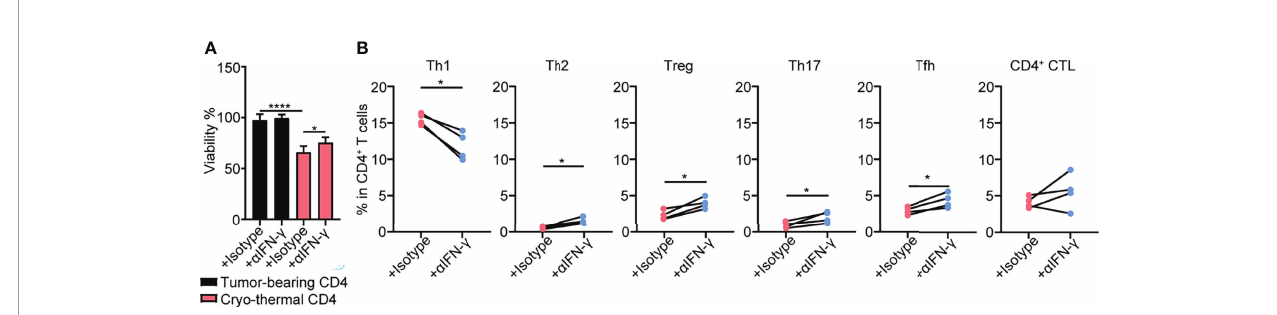
FIGURE 5 | Tumor growth inhibition and Th subsets of CD4 + T cells in vitro . (A) Viability of tumor cells. Tumor cells were cocultured with tumor-bearing or cryo- thermal CD4 + T cells at 8:1 of E:T ratio in the presence of 10 m g/mL isotype or anti-IFN- g antibody. Twenty-four hours later, the viability of tumor cells was detected by CCK-8 Kit. (B) Percentage of Th subsets. Cryo-thermal CD4 + T cells were stimulated by 1 m g/mL anti-CD3 antibody in the presence of 10 m g/mL isotype or anti- IFN- g antibody. Three days later, Th subsets were detected by fl ow cytometry. All data were shown as mean±SD. n =4 for each group. *P < 0.05, **P < 0.01, ***P < 0.001, ****P < 0.0001. Data for graphs